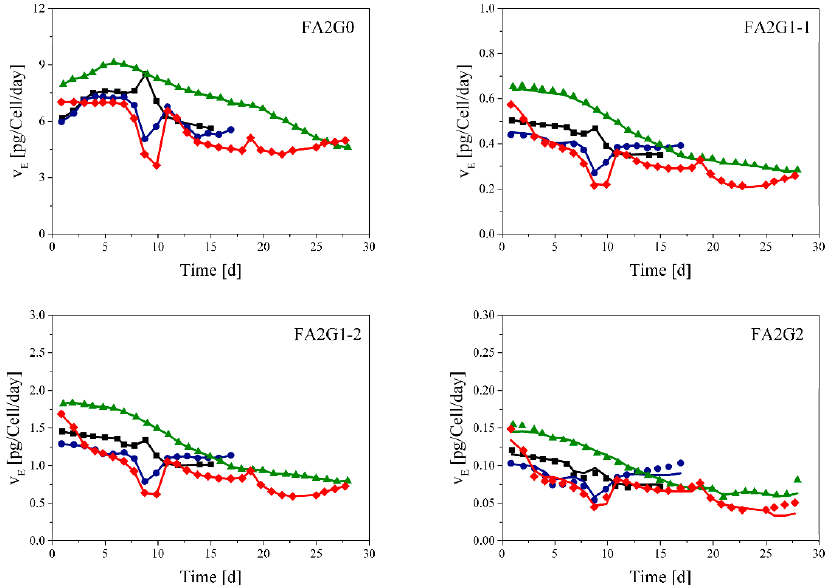
Figure 5. Secretion fluxes of the main IgG glycoforms. The solid symbols show the experimental secretion fluxes computed in the data preprocessing step, as outlined in Section 2.2 (Experiment A: black squares, Experiment B: blue circles, Experiment C: green triangle, Experiment D: red diamonds). The lines show the secretion fluxes from the fitting of 𝛼 𝐽 in the GFA, as outlined in Section 2.3.